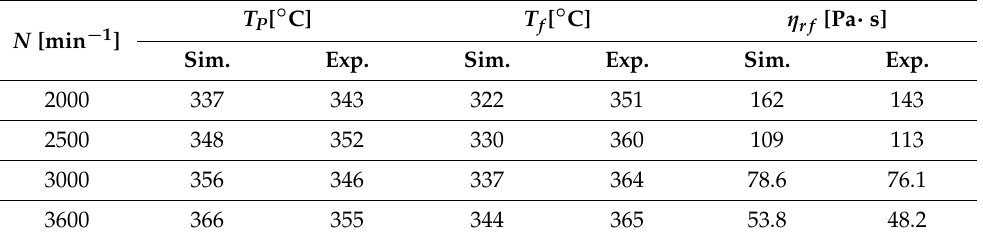
Table 3. Simulation and experimental results of temperature at point P , denoted by T P , outlet temperature T f , and outlet reference zero-shear viscosity η rf in experiment 1.